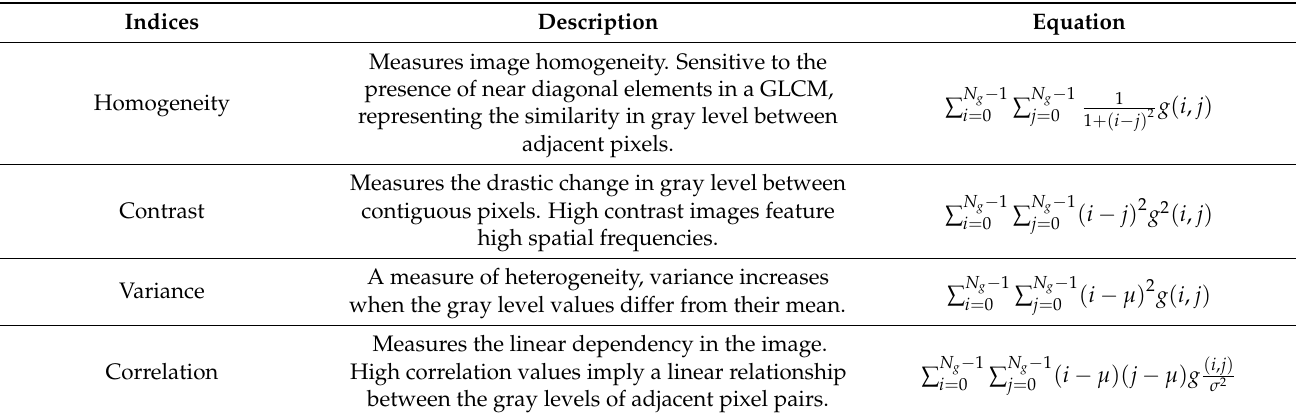
Table 2. Selected GLCM indices. Indices Description Equation Measures image homogeneity. Sensitive to the presence of near diagonal elements in a GLCM, Homogeneity representing the similarity in gray level between adjacent pixels. Measures the drastic change in gray level between contiguous pixels. High contrast images feature high spatial frequencies. A measure of heterogeneity, variance increases when the gray level values differ from their mean. Measures the linear dependency in the image. High correlation values imply a linear relationship between the gray levels of adjacent pixel